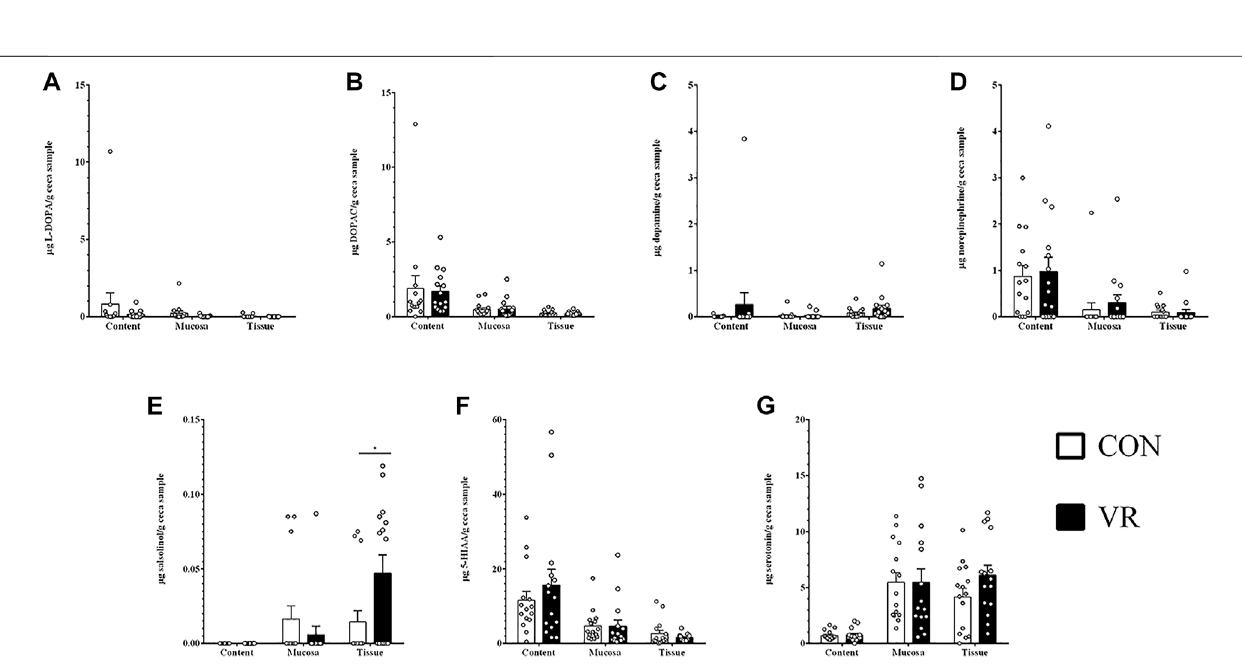
Frontiers in Virtual Reality |